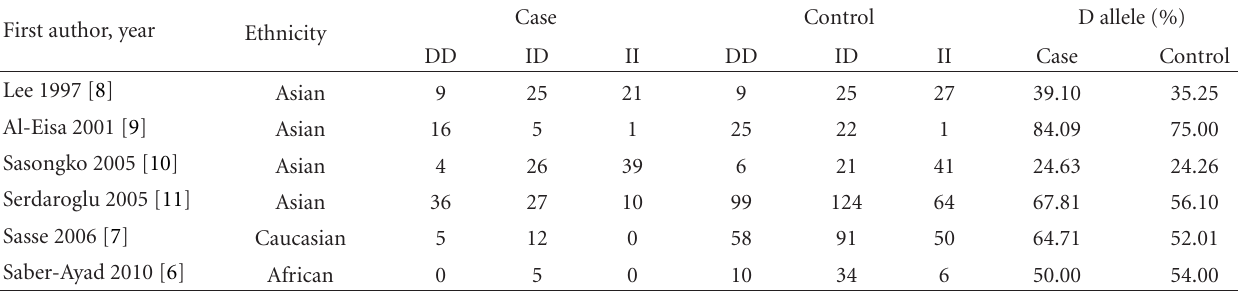
Table 1: Characteristics of the studies evaluating the e ff ects of ACE genes on MCNS